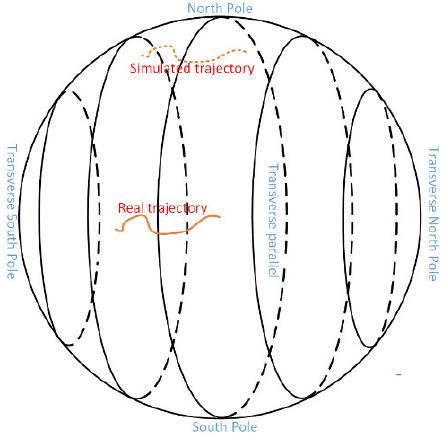
Figure 2. Simple demonstration of the reference trajectory transfer. The measured IMU data is converted into simulated IMU data through IMU data conversion.